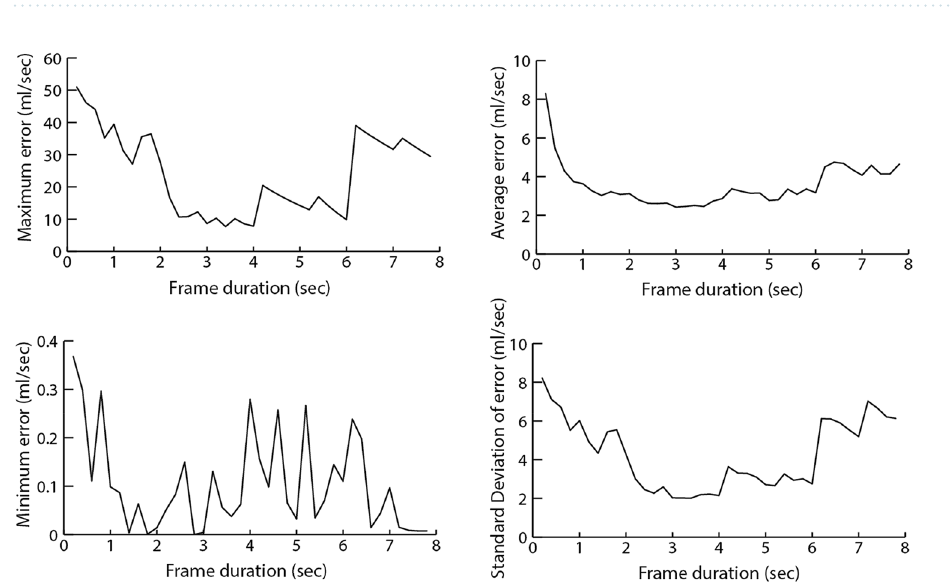
Figure 5. How Q max error rate statistics vary with frame